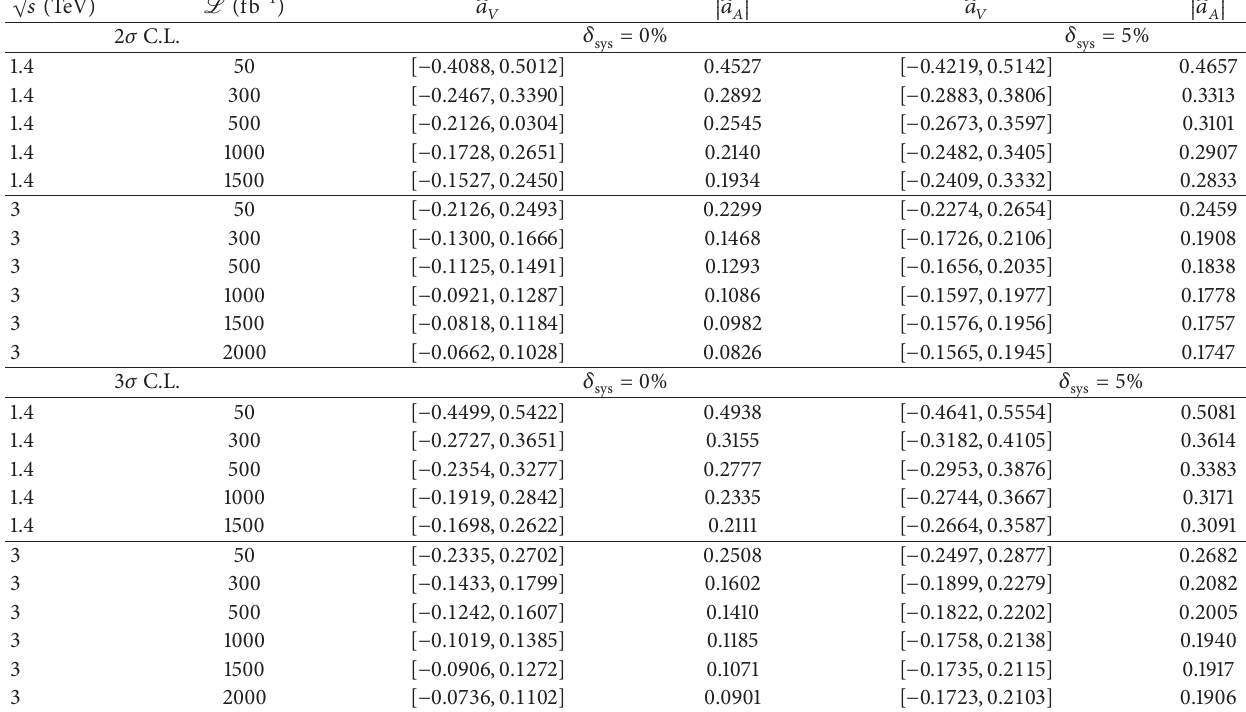
Table 5: Bounds on the ̂𝑎 𝑉 magnetic moment and ̂𝑎 𝐴 electric dipole moment for the process 𝑒 + 𝑒 − → 𝑒 + 𝛾 ∗ 𝑒 − → 𝑡𝑏 ] 𝑒 𝑒 + ( 𝛾 ∗ is the Weizsacker-